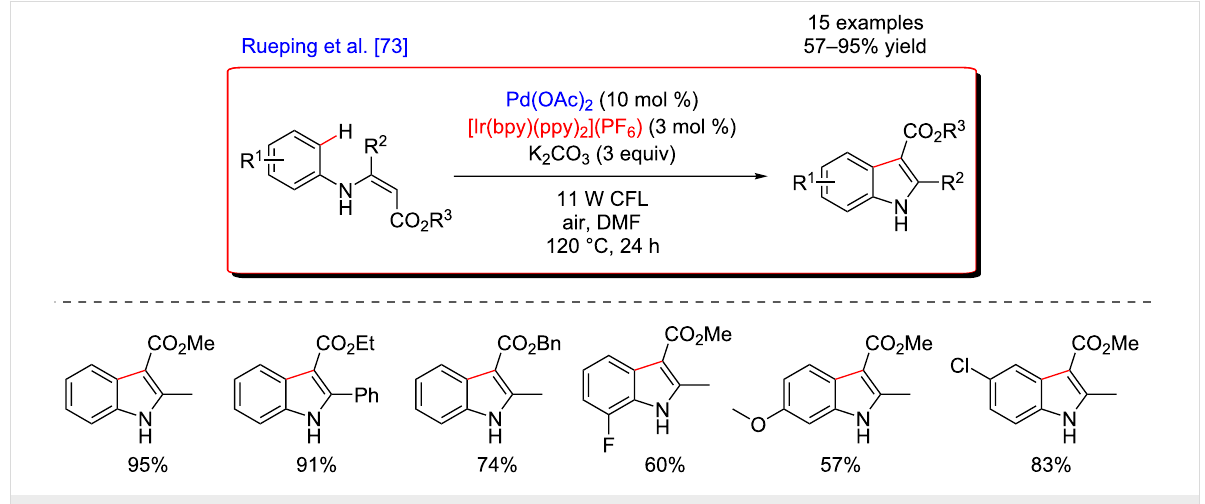
Figure 5: Indole synthesis via dual C–H activation/photoredox